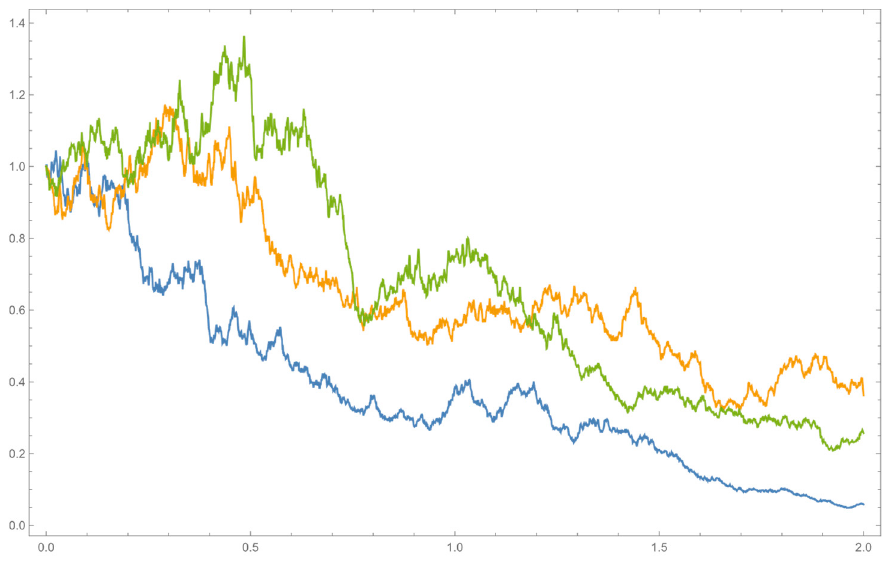
Figure 1. Three sample paths for the optimal debt ratio.